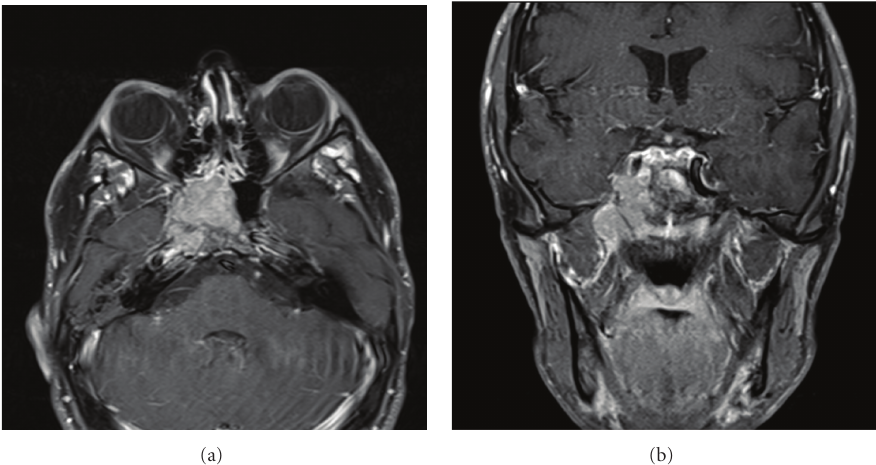
Figure 4: Axial and coronal T1-weighted, gadolinium-enhanced MR imagingrevealing a homogenouslyenhancing lobulated lesioncentered within the right sphenoid sinus with extension into the carotid canal, pterygopalatine fossa, and optic nerve